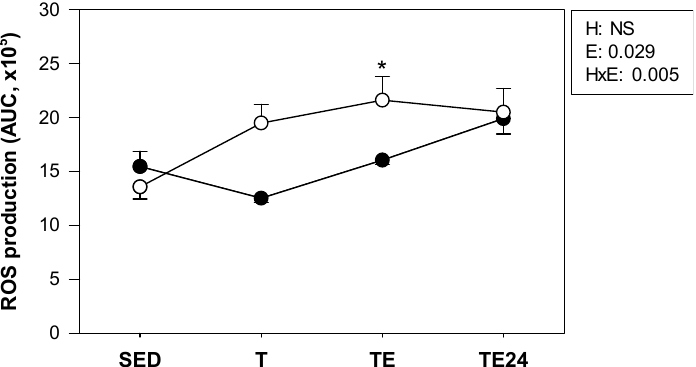
Figure 4. Production of ROS by peritoneal macrophages at the end of the study (AUC from 0 to 150 min). The non-supplemented groups are represented by white symbols ( ⚪ ) and the hesperidin groups by black symbols ( ⚫ ). SED = sedentary group, T = trained group, TE = T group with an additional exhaustion test, TE24 = TE group 24 h after the exhaustion test, NS = no statistically significant differences detected. Data are expressed as mean ± SEM ( n = 5–6). Statistical difference: the inset table shows two-way ANOVA results when applied (H, hesperidin; E, exercise; HxE, interaction between hesperidin and exercise). * p < 0.05 vs. the SED group just in the non-supplemented animals.